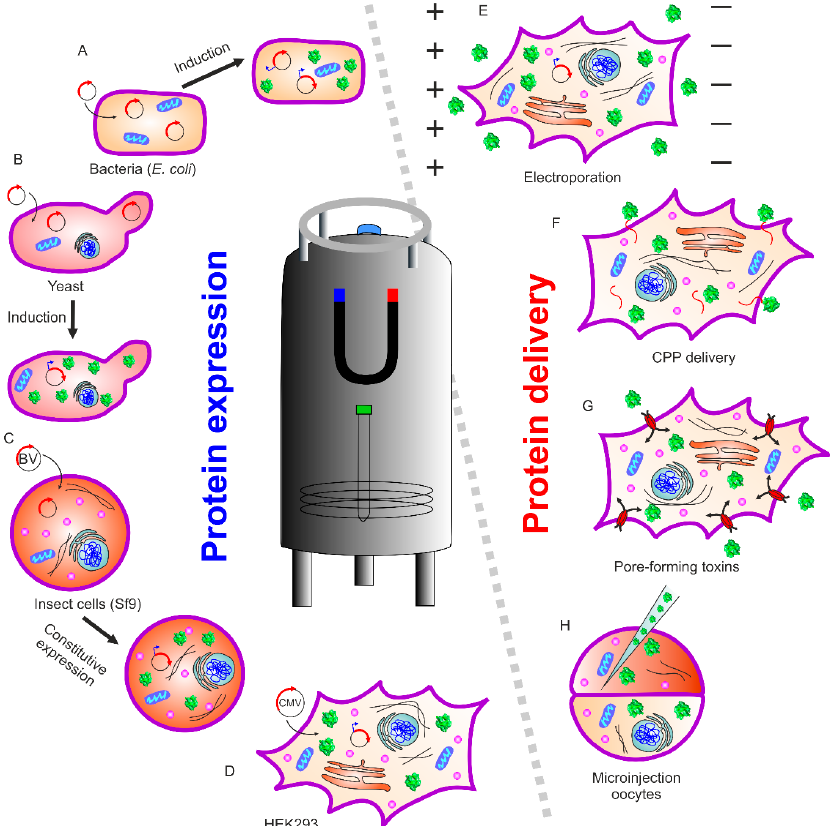
Figure 1. Schematic overview of different known approaches in in-cell NMR. (Left) Endogenously expressed and isotopically labeled protein can be achieved by transferring the expression vector containing the gene of interest into ( A ) bacteria, ( B ) yeast, ( C ) insect cell lines, and ( D ) mammalian cells. (Right) An alternate way of in-cell NMR, where isotopically labeled protein is exogenously prepared followed by delivery into eukaryotic cells with different methods such as ( E ) electroporation, ( F ) attaching protein with cell-penetrating peptides (CPP), ( G ) protein transport via pore-forming toxins, and ( H ) microinjection-mediated delivery into Xenopus leavis oocytes. Different types of isotope labeling of protein samples for in-cell NMR are available.